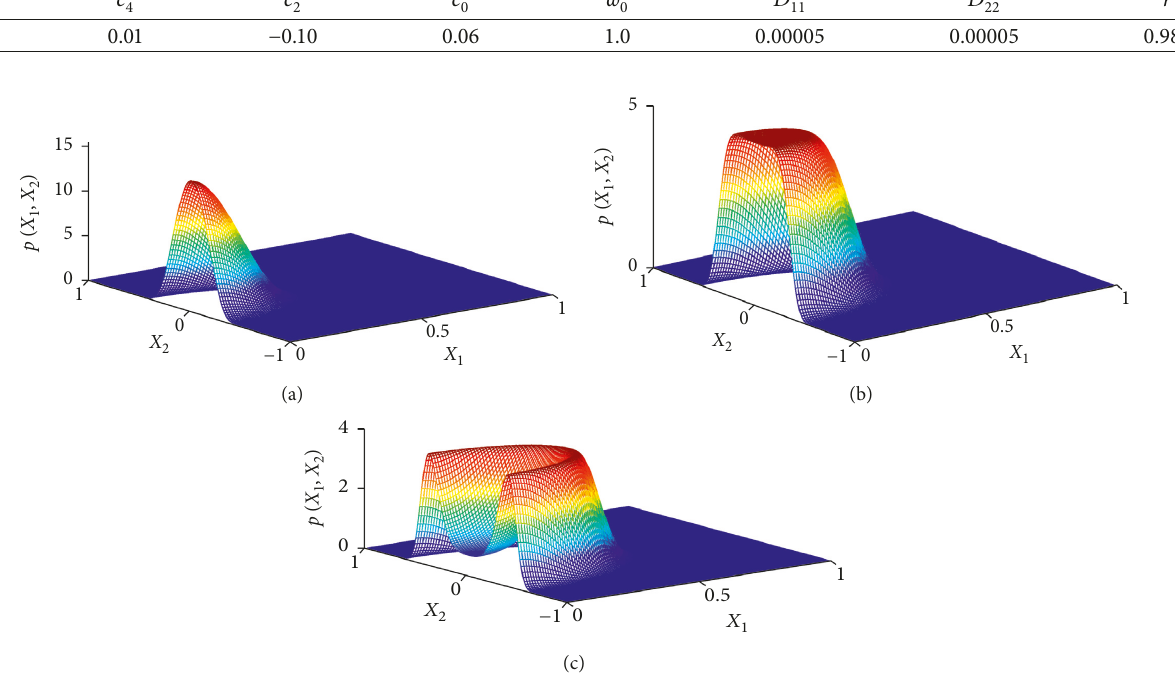
Figure 5: The joint probability density function for different β . (a) β � 0 . 009. (b) β � 0 . 006. (c) β � 0 . 003.